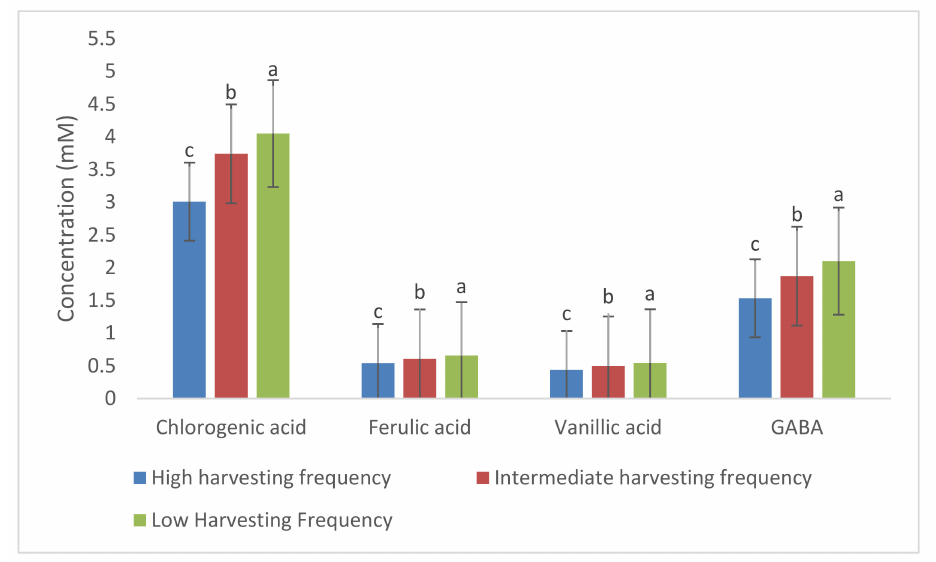
Figure 8. Comparison of mean concentration (mM) of M. oleifera leaf chlorogenic acid, ferulic acid, vanillic acid, and gamma-aminobutyric acid (GABA) between low, intermediate and high harvesting frequency plants ( p ≤ 0.05). Different letters (a, b and c) indicate that the mean of three harvesting group were significantly different from each other. n = 8 (high harvesting frequency), n = 6 (intermediate harvesting frequency), and n = 4 (low harvesting